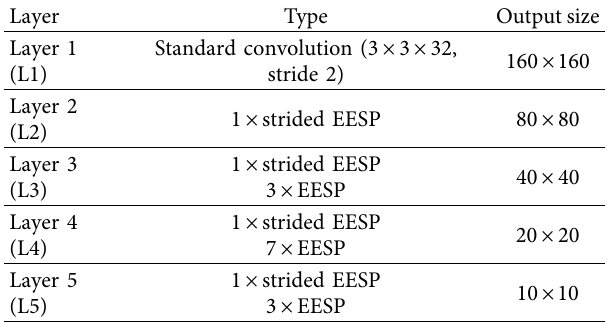
Table 2: The structure of ESPNetv2 used in this